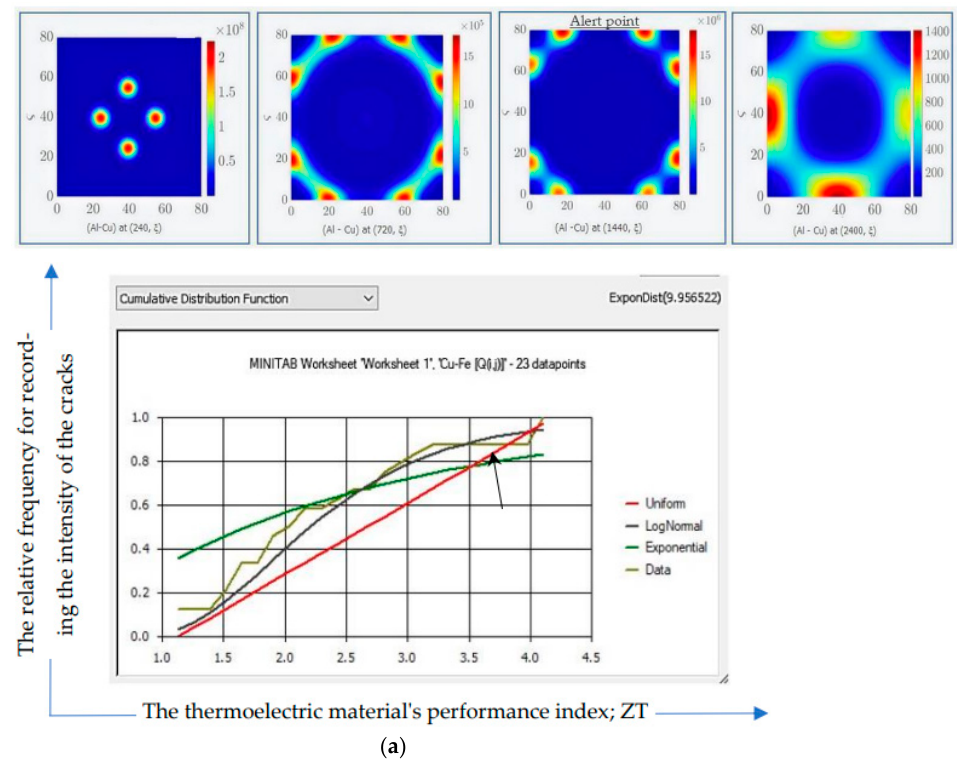
Figure 7. The change in the gasket (Al − Cu) alloy resistance working conditions for thermal transfer. a: The behavior of the cracks’ growth through 23 weeks for Cu − Fe alloy is exponential. Therefore, the authors’ experiment uses a gasket lined on both sides, (Al-Fe) on the upper face and (Al-Cu) on the lower face. The authors tend to increase the thickness of the gasket alloy layer to 1.74 mm. The spatiotemporal evolution tracks the gasket terminals’ cracks for the (Al-Fe) and the (Al-Cu) as illustrated in Figure 8, during 𝑡 = (1440; 2400) working hours when 𝑅 (cid:2868) > 1 (51 < b < 100), for which the ramifications increased to 100. Although the thickness increased, the films show the cracks exacerbate according to the ramification regression as illustrated in Figure 8, but resists for more than 2400 working hours, with 𝐷𝑥 = 𝐷𝑦 = 𝐷 v = 0.2.